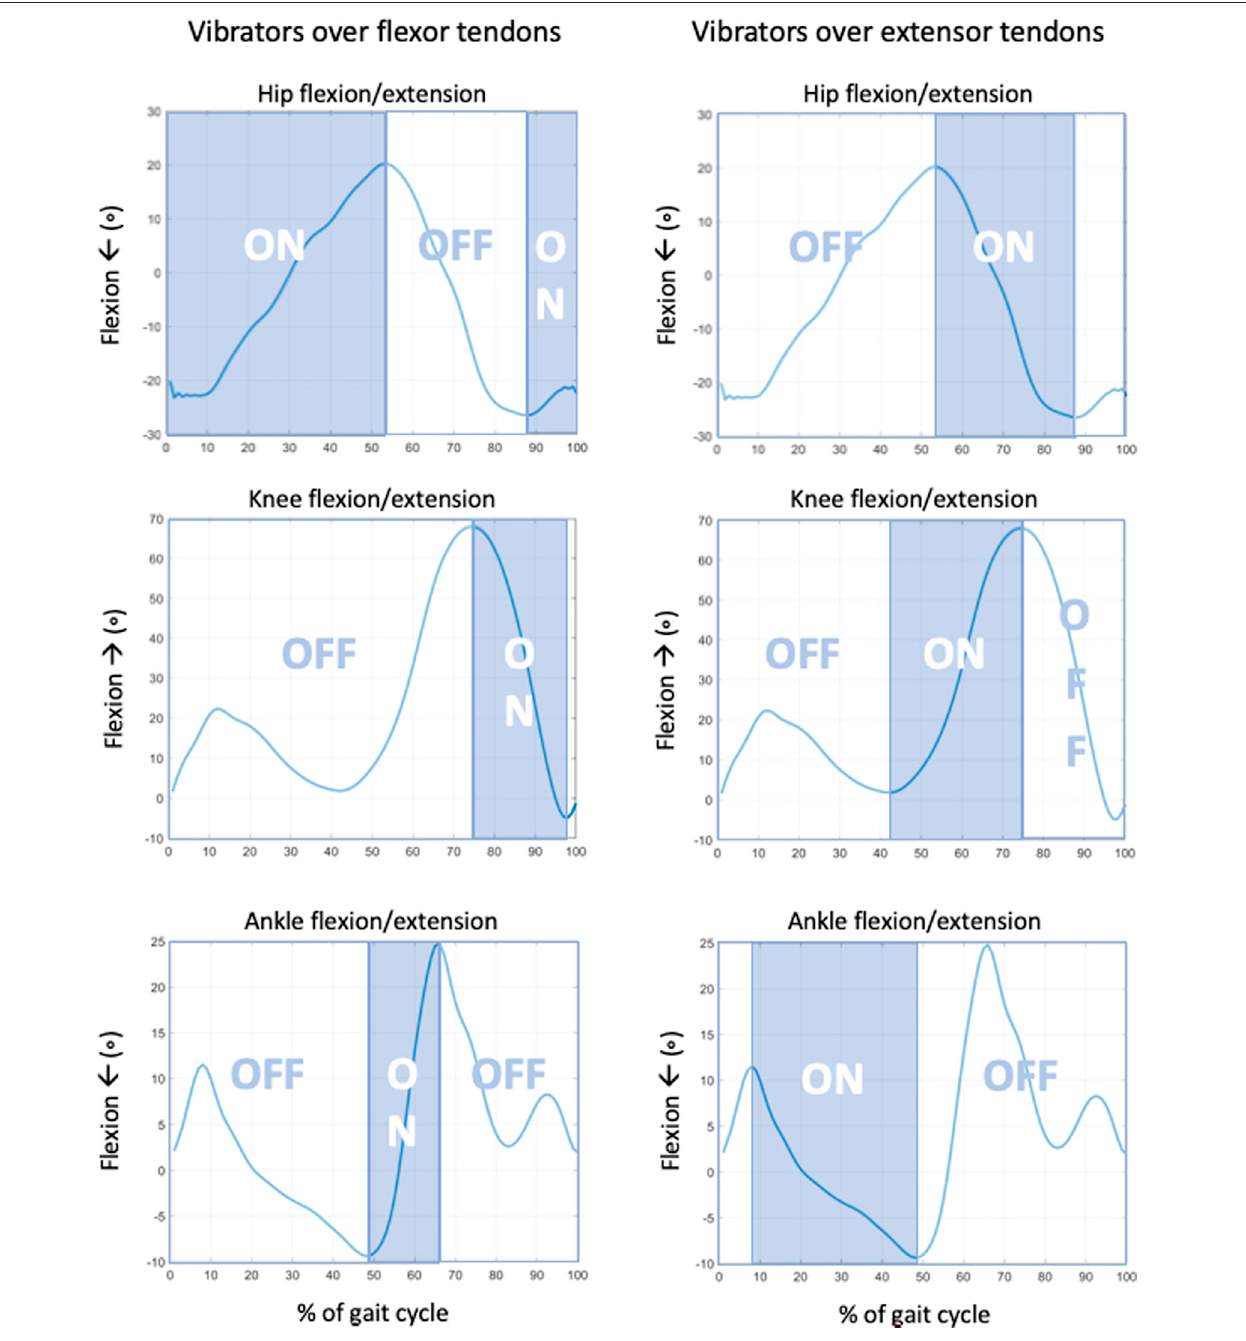
FIGURE3| Kinematicdataofthehips (top) ,knees (middle) ,andankles (bottom) usedtoanimatetheavatarandtotriggerthevibratorsonthe fl exormuscles (left column) and on the extensor muscles (right column) . Vibrators were turned on (ON) on fl exor muscles (left column) when joint moved toward extension and on extensormuscles (leftcolumn) whenjointmoved toward fl exion,tomimic musclesensoryactivity associatedwithmuscle lengthening. Vibrators wereoff(OFF) therest of the time.